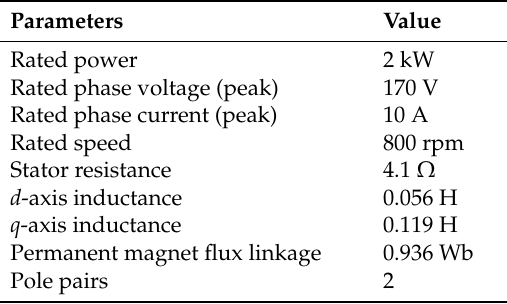
Table 1. Parameters of the interior permanent magnet synchronous motor (IPMSM).